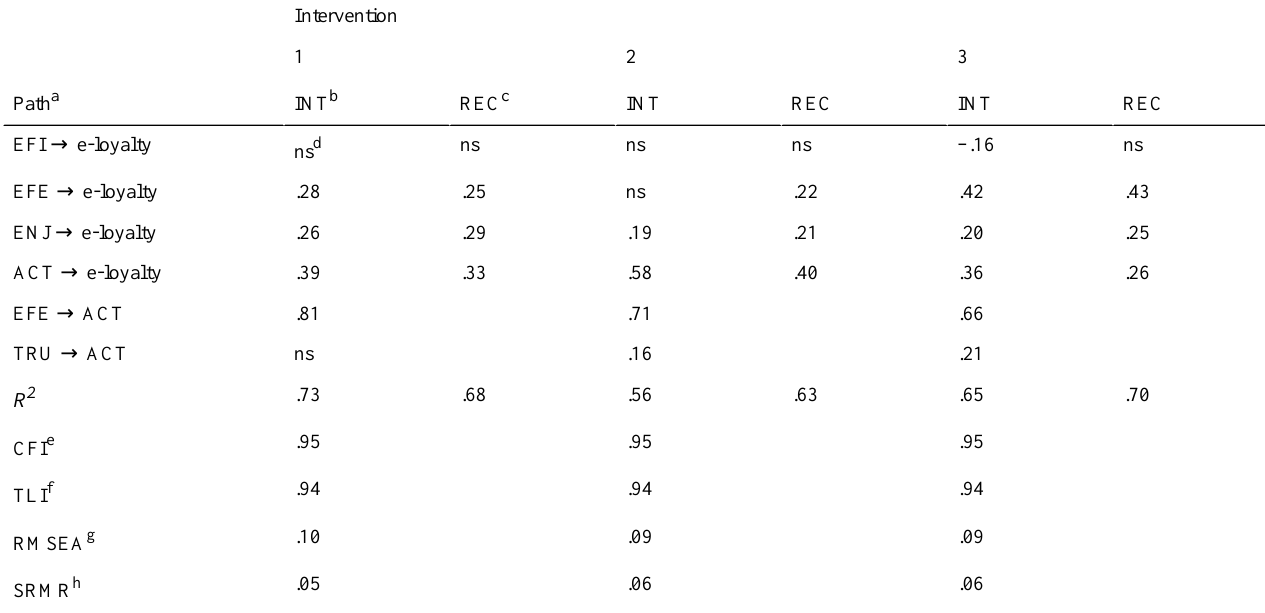
Table 4. Results of conceptual model (figures are standardized betas of paths within the